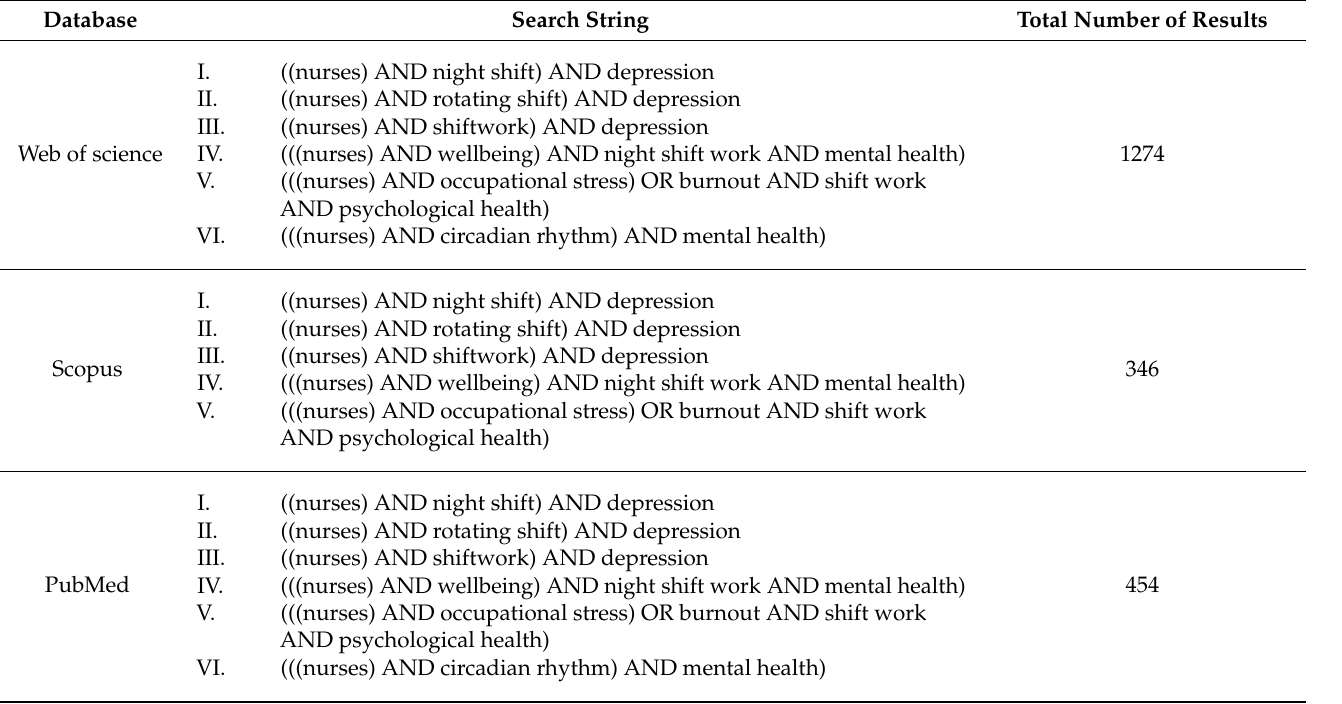
Table 1. Literature search strings used in the